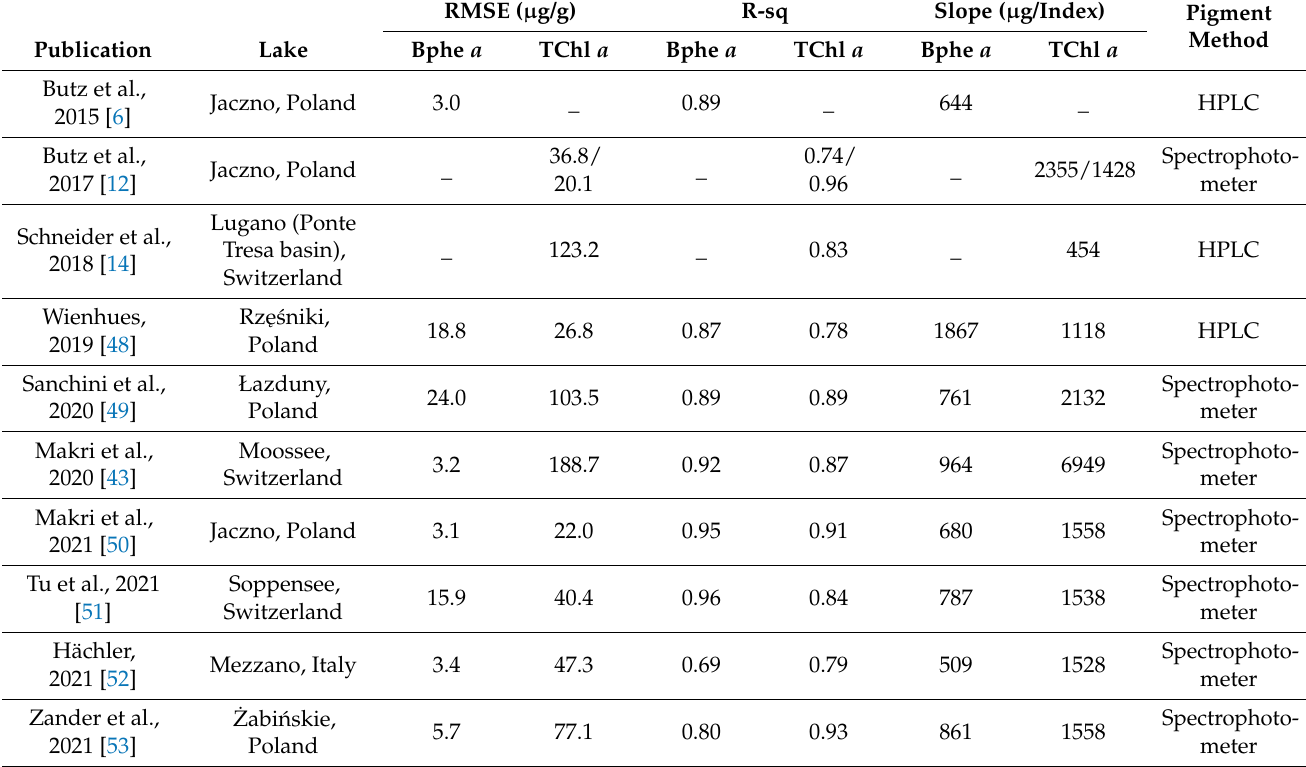
Table 3. Summary of published pigment calibrations using hyperspectral imaging spectral